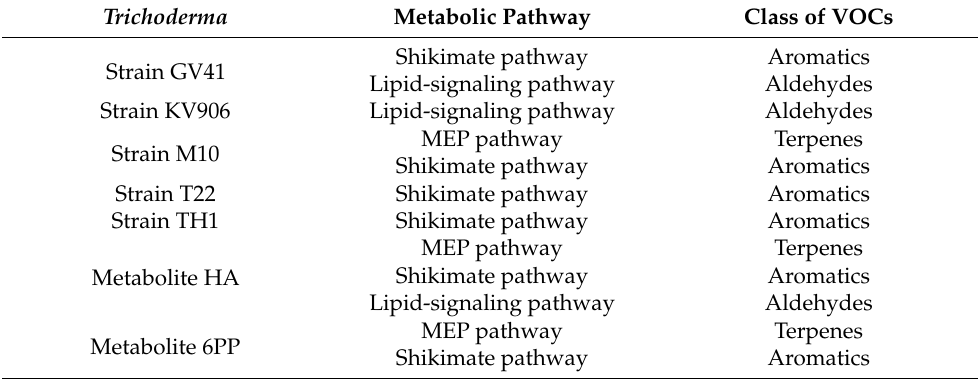
Table 4. Olive VOC biosynthetic pathways possibly affected by Trichoderma applications (strains or